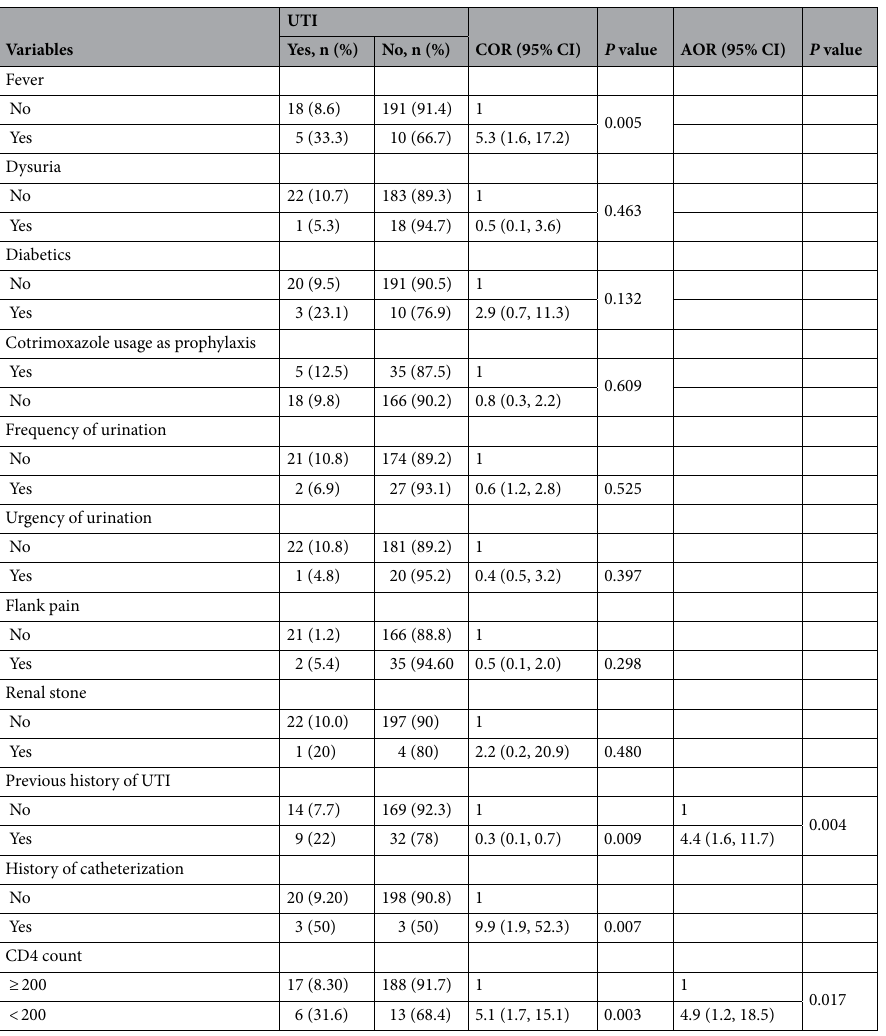
Table 3. Bivariate and multivariate analysis of clinical characteristics and UTI among people living with HIV who were attending Hawassa University Comprehensive Specialized Hospital ART clinic, Hawassa, Ethiopia, from September 17 to November 16,2018 (n = 224). AOR adjusted odds ratio, COR crude odd ration, AOR adjusted odd ratio, CI confidence interval, n